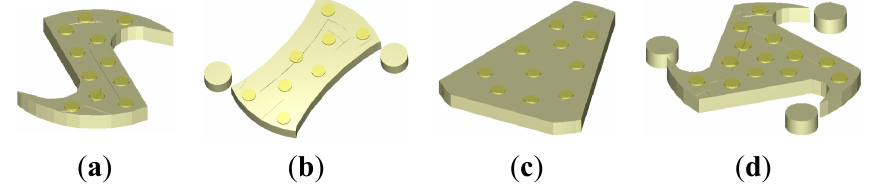
Figure 3. Models of the different microrobot designs derived from the mask layout, rendered in MEMSPro. The designs are referred to as: ( a ) “S”, ( b ) bar, ( c ) “wedge”, and ( d ) “star”. Each device is approximately 200 μm in diameter.